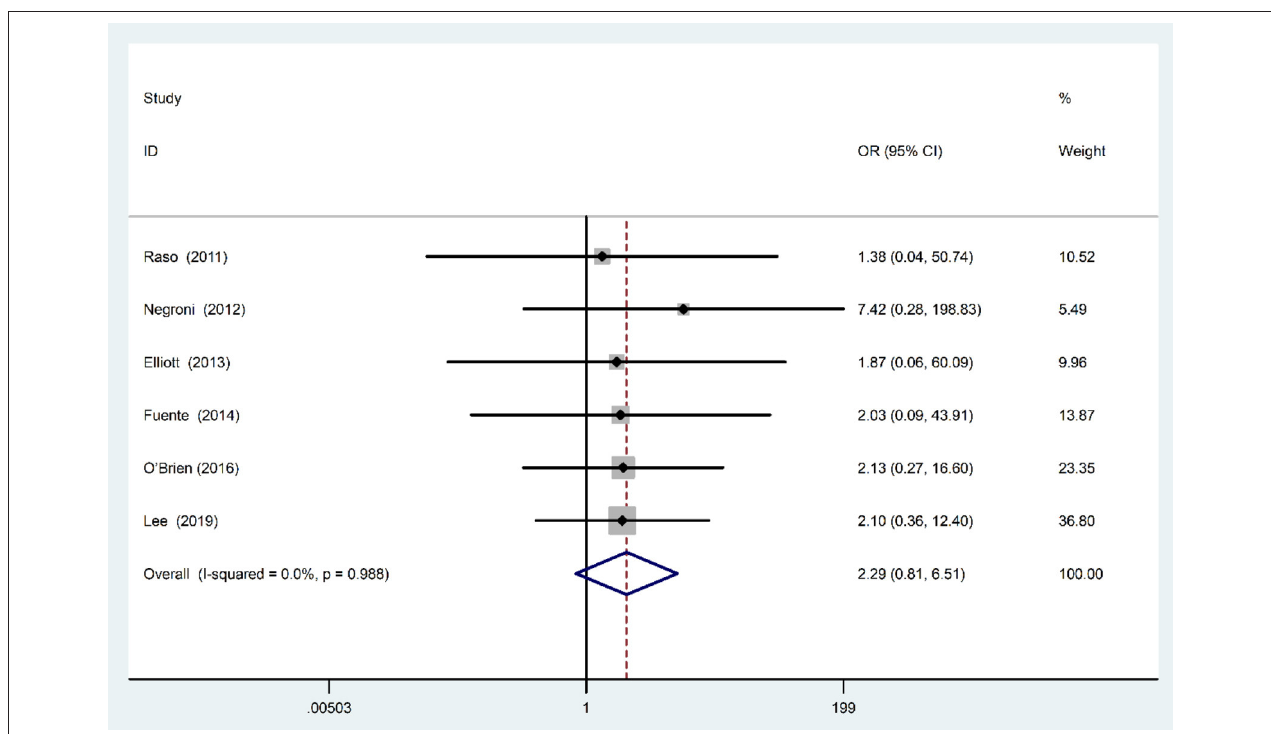
FIGURE 5 | Forest plot of the association between AIEC rate and risk of